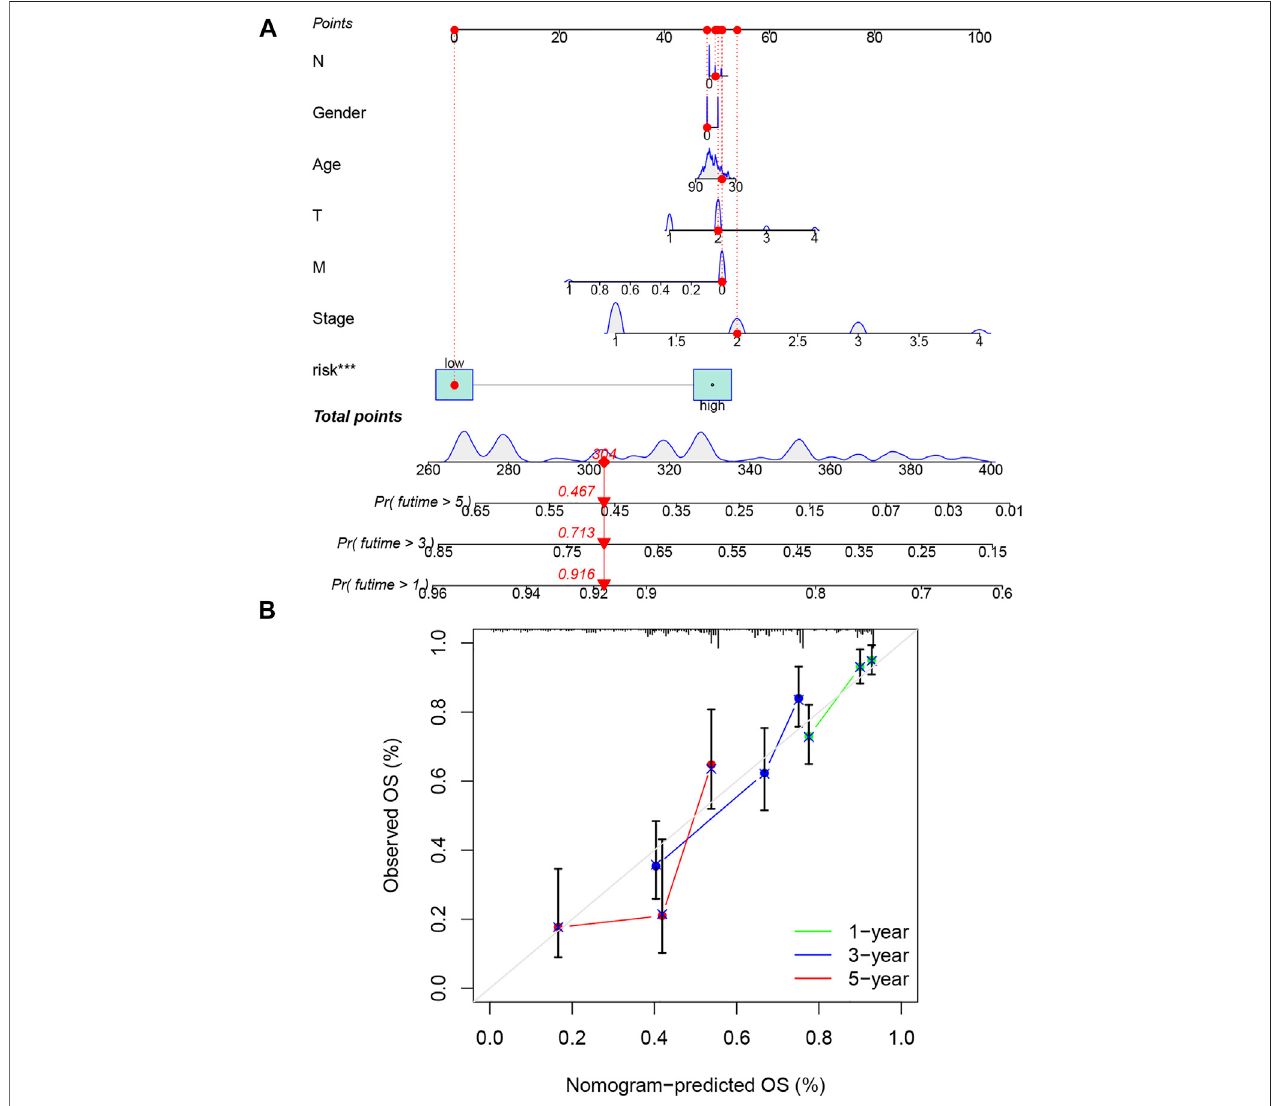
FIGURE5| Constructionandveri fi cationofthenomogram. (A) Anomogram combining clinicopathologicalvariablesand riskscorepredictsthe1-,3-,and5-year overall survival of lung adenocarcinoma patients. (B) The calibration curves test the consistency between the actual outcome and the predicted outcome at 1, 3, and 5